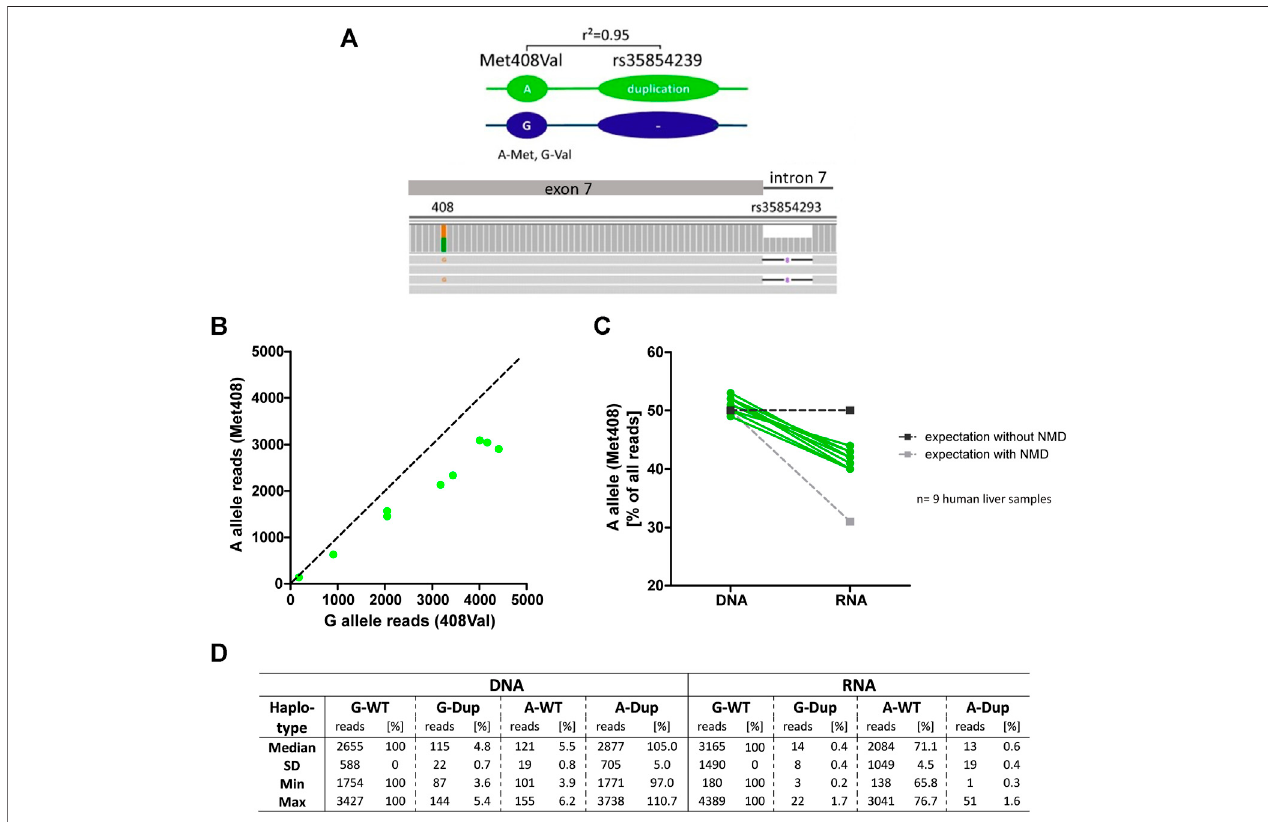
FIGURE 5 | Allelic expression imbalance in heterozygous carriers of rs35854239 (A) The duplication allele of rs35854239 is highly linked to the A-allele of Met408. The abundance of both Met408Val alleles was analyzed on DNA and RNA level in heterozygous Met408Val/rs35854239 human liver samples using deep RNA- sequencing. (B) The abundance of both Met408Val alleles on RNA level was analyzed and (C) the percentage of the A-allele (Met408) on DNA and RNA levels was compared in nine human liver samples (green). Dashed lines represent expected allele balance without (dark gray) and with (light gray) non sense-mediated mRNA decay (NMD). (D) Sequencing depth is given in absolute reads and relative to the Val408 G-allele and rs35854239 wild-type haplotype.